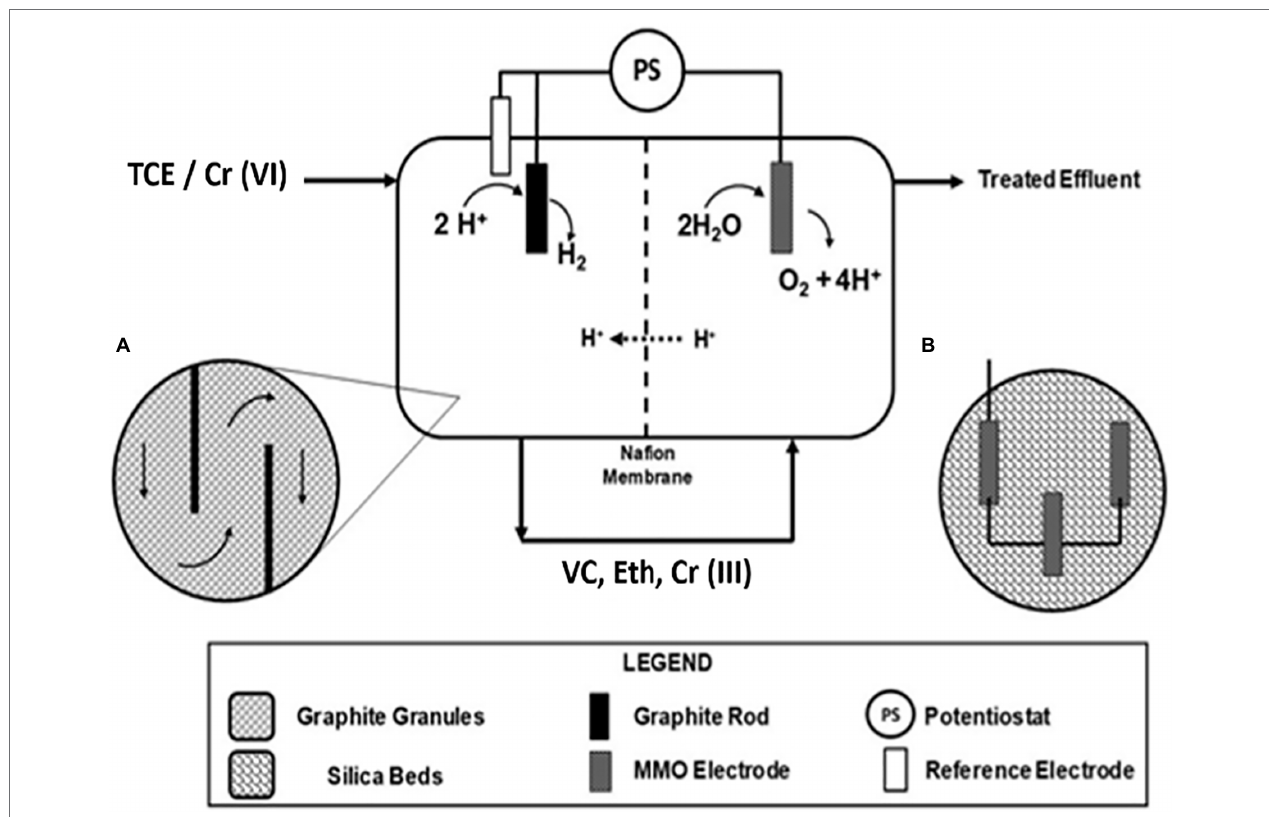
FIGURE 1 | Scheme of the continuous flow bioelectrochemical reactor for the trichloroethylene (TCE) and Cr(VI) removal. Horizontal cross section detail of the cathodic chamber (A) and schematic representation of the MMO (Magneto special Anodes, Netherland) electrode inserted in the silica bed (B)